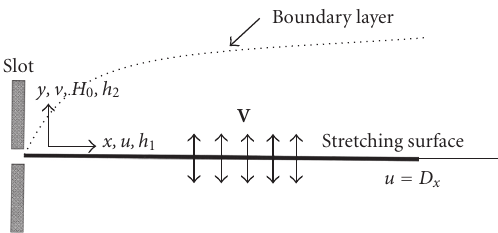
Figure 2.1. Coordinate system for the physical model of the stretching